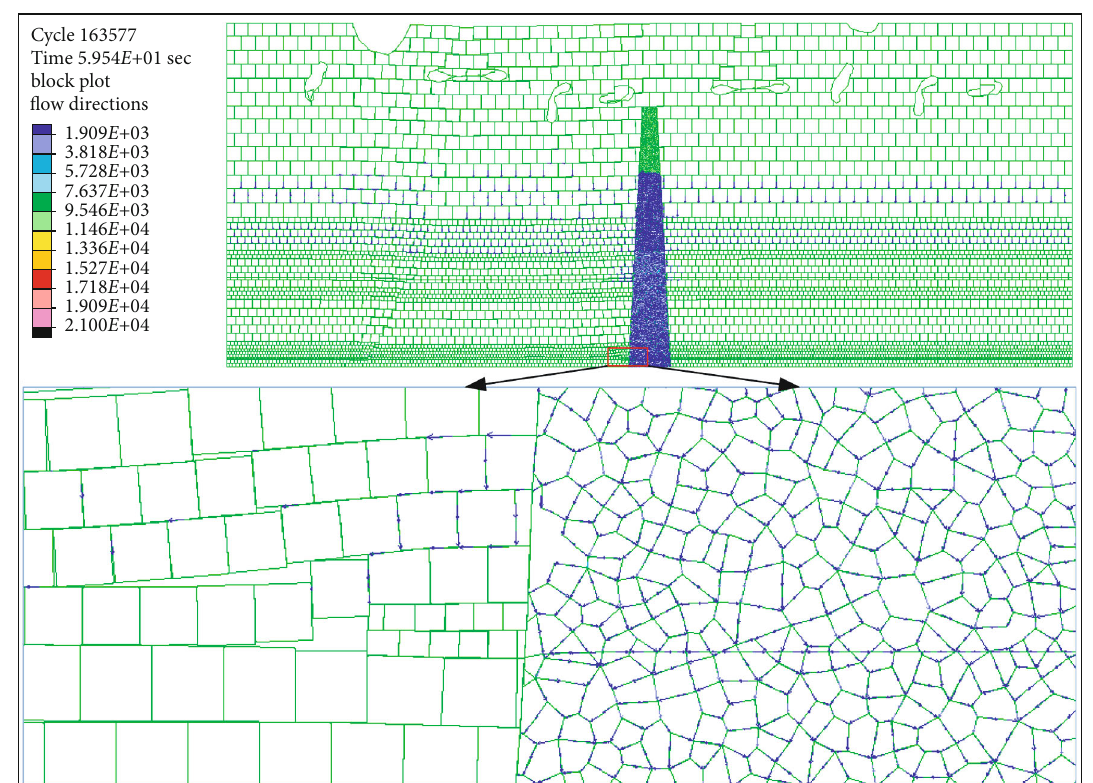
Figure 6: The velocity diagram of water fl ow (the mining distance is 280